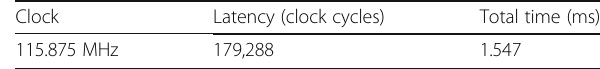
Table 6 Second approach OCR algorithm performance